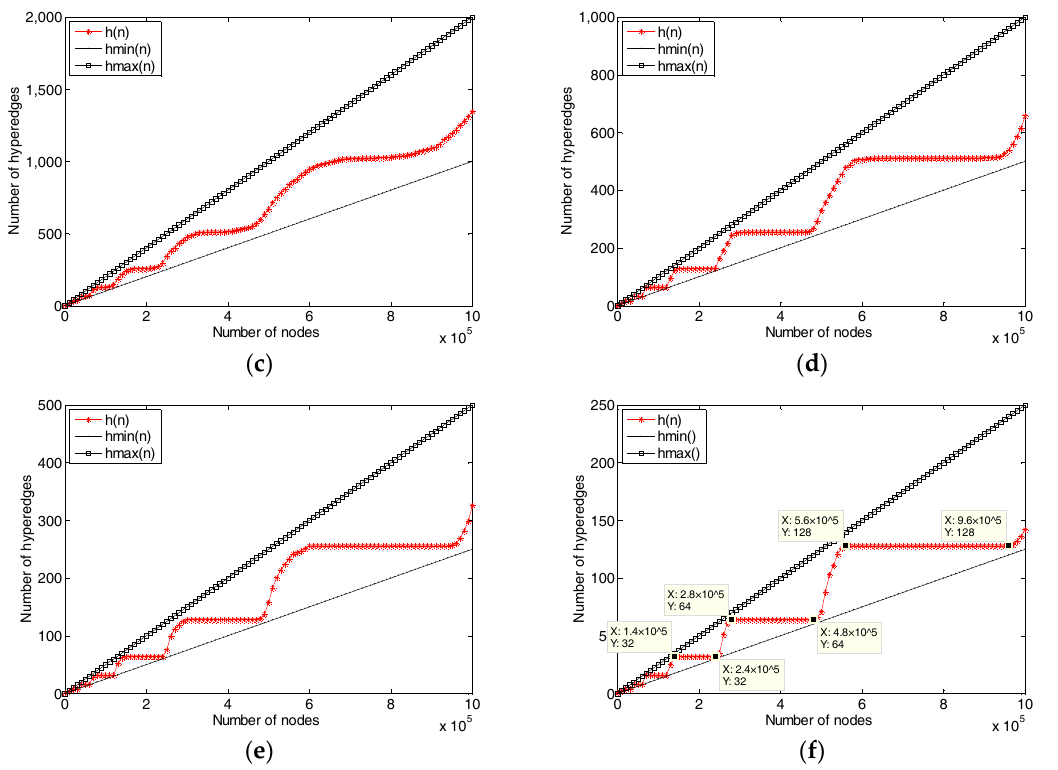
Figure 10. The network evolution with different C, ( a ) C = 100, ( b ) C = 500, ( c ) C = 1,000, ( d ) C = 2000, ( e ) C = 4000, ( f ) C = 8000.